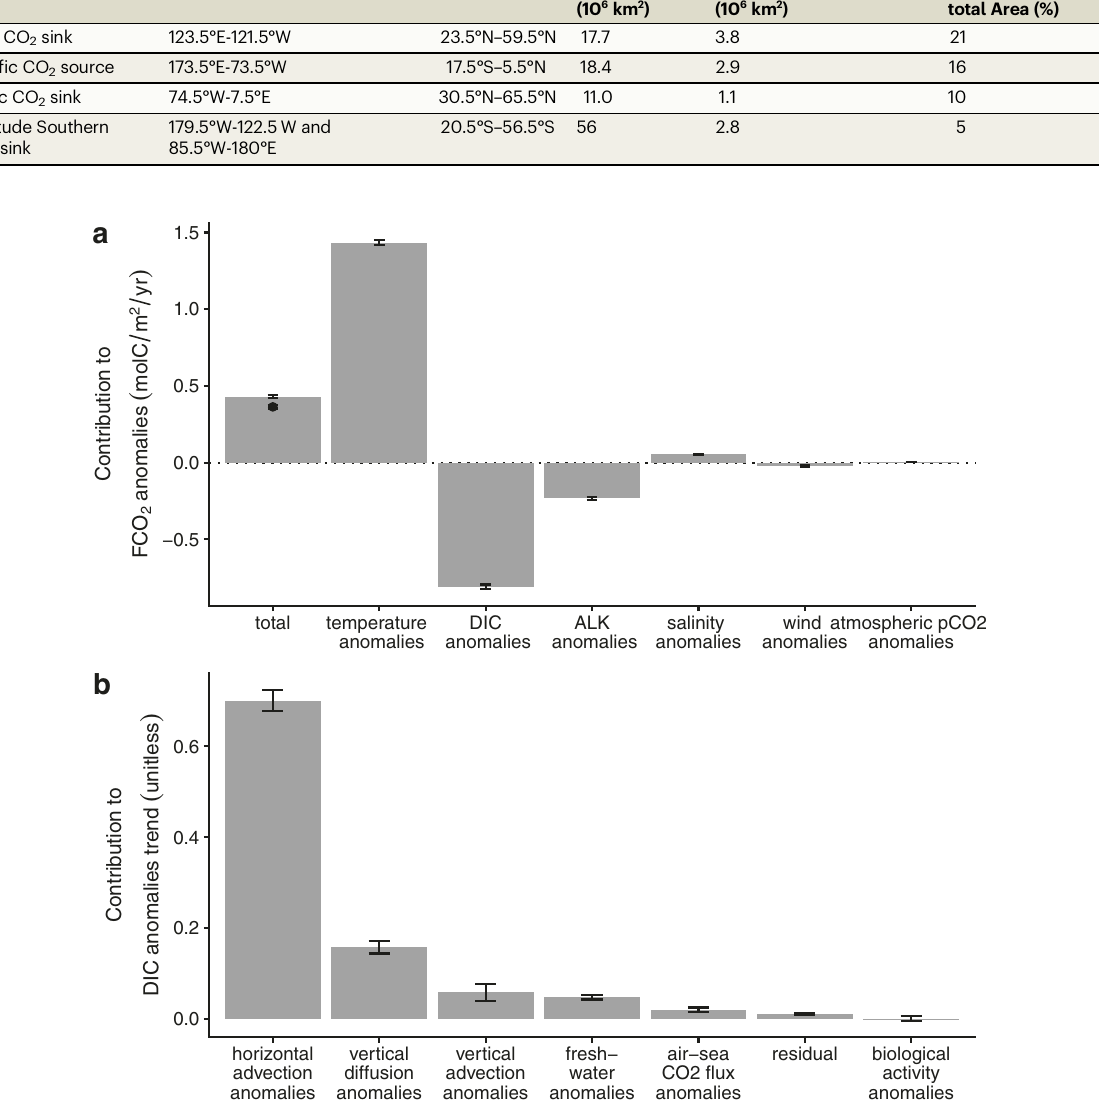
Fig. 2 | Processes that lead to a reduction in the oceanic uptake of CO 2 in the North Paci fi c during PMHWs. a 2009 – 2017 average F CO2 anomalies (black dot) and its Taylor decomposition (vertical bars). The contribution of temperature, Dissolved Inorganic Carbon (DIC), Alkalinity (ALK), salinity, wind and atmospheric partial pressure of CO 2 to F CO2 anomalies observed during PMHWs in the North Paci fi cCO 2 sinkregionforthe2009 – 2017periodwerecalculatedusinga fi rstorder Taylor expansion derived from the biogeochemical reanalysis (see methods sec- tion). The “ total ” bar corresponds to the sum of all contributing terms and corre- sponds to the Taylor approximation of F CO2 anomalies (black dot). The good agreement between the two implies that F CO2 anomalies are well approximated by